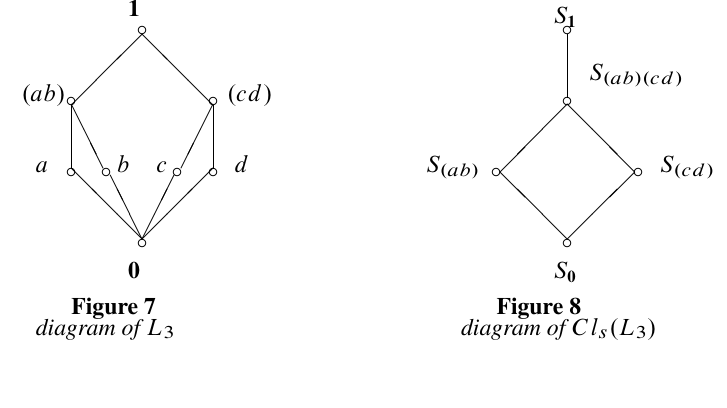
Figure 8 diagram of Cl s .L 3